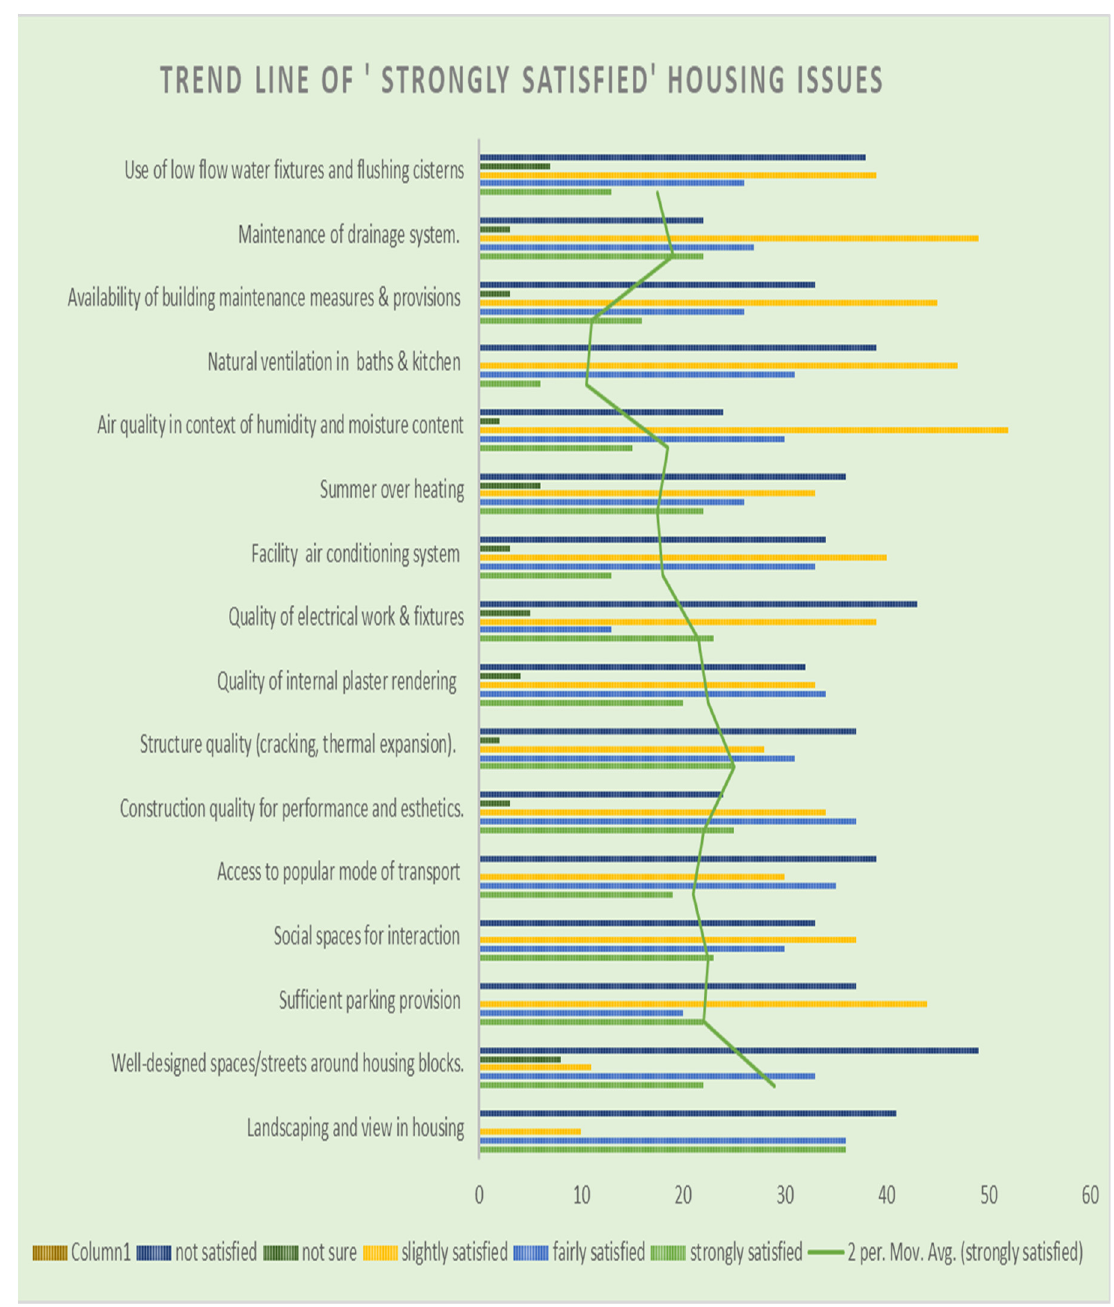
Figure 8. “Strongly satisfied” trend.